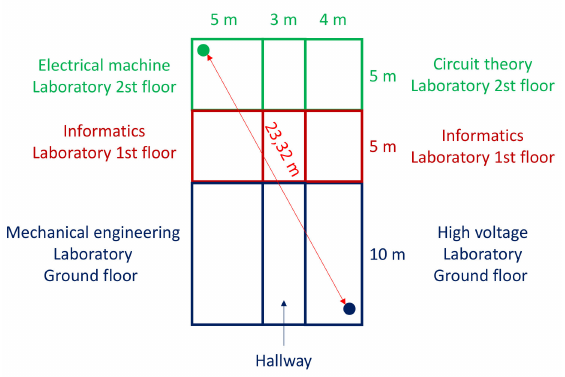
Figure 7. Section of the A3 building showing the obstacles between the PAMPD and gateway.